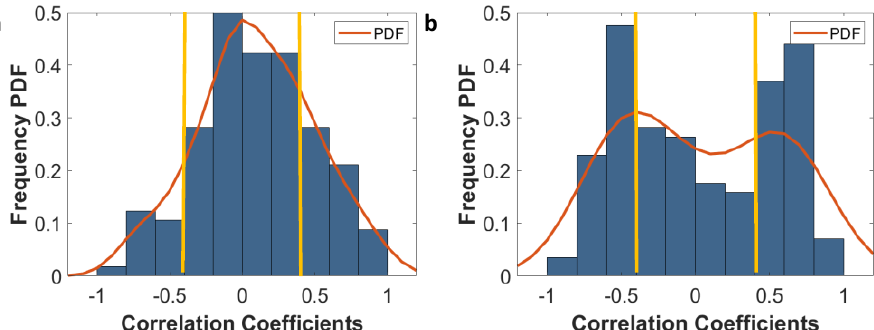
Figure 7. ( a ) Frequency distribution of the SCC between the change in radiomic features ( ∆ FeatureValue) to change in volume ( ∆ V) along with the underlying probability density function (PDF) of the distribution (in red) for T1w. ( b ) Frequency distribution of the SCC between the change in radiomic features ( ∆ FeatureValue) in relation to change in volume ( ∆ V) along with the underlying PDF of the distribution (in red) for T2w. The yellow line signifies the − 0.4 to 0.4 interval, i.e., where ∆ FeatureValues are considered insensitive to ∆ Volume.